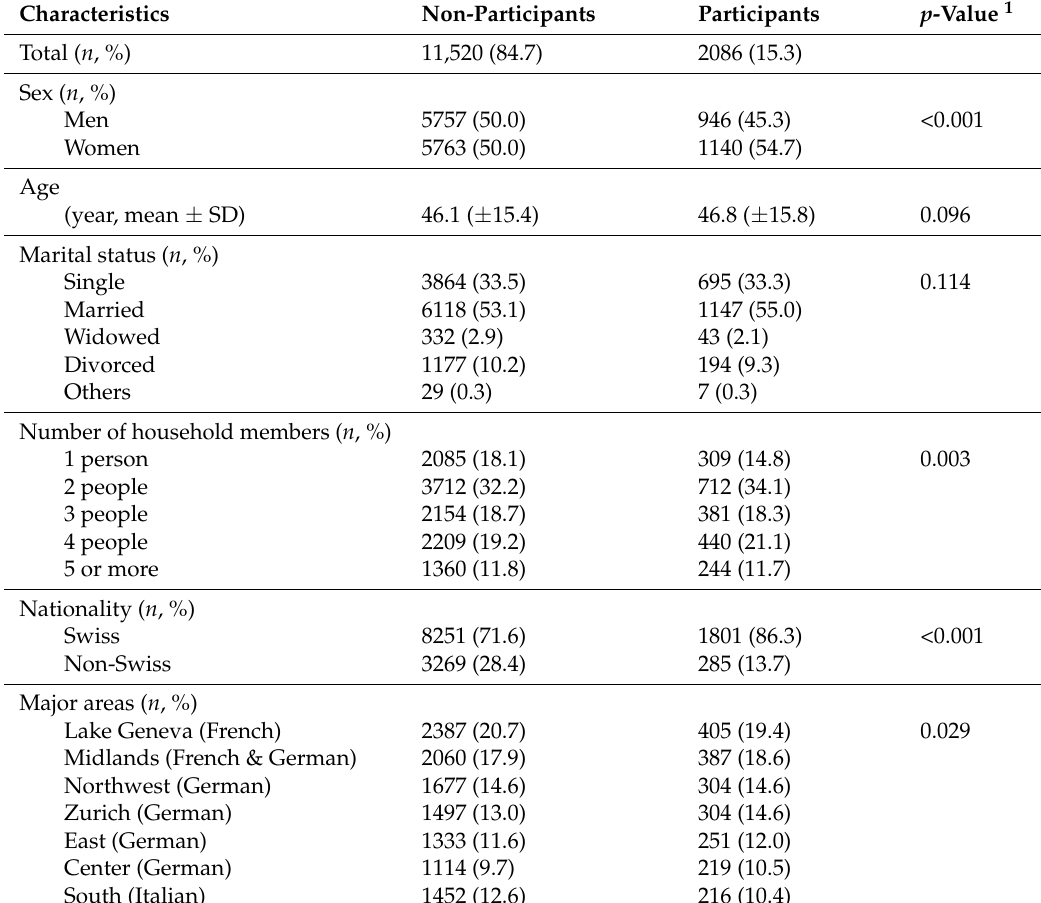
Table 1. Characteristics of participants vs. non-participants, Swiss Nutrition Survey,